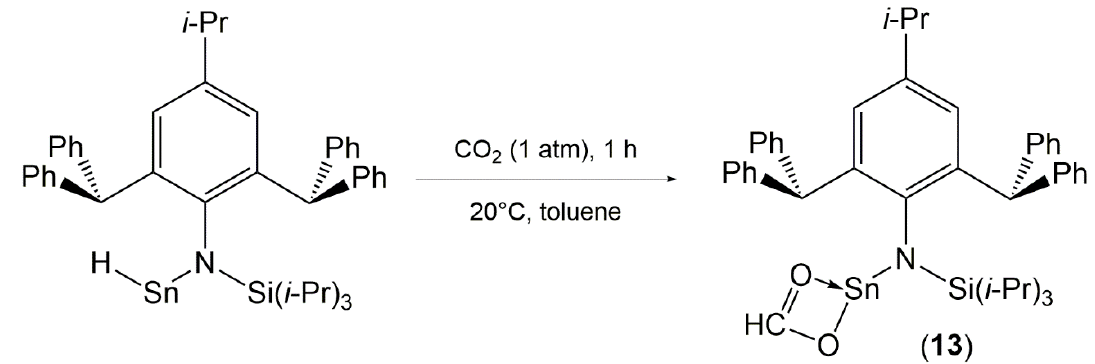
Scheme 20. Reaction scheme leading to Compound 13 , data from [67].